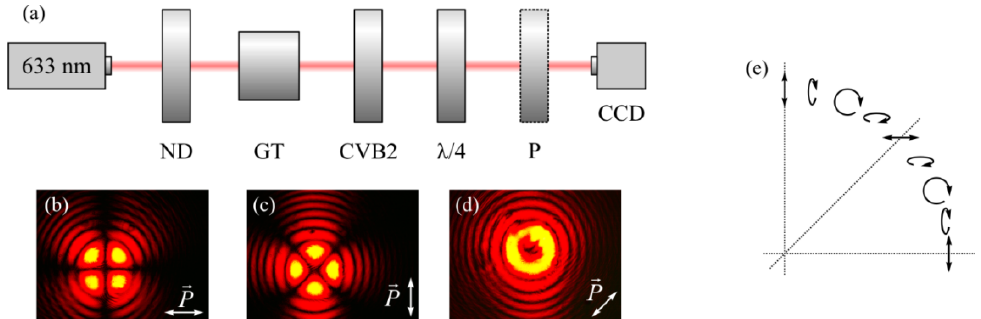
Figure 8. ( a ) Optical setup for the generation and registration of a hybrid polarized beam (Equation (1)) of the second-order m = 2, with the analyzer placed ( b ) horizontally ( θ = 0 degrees), ( c ) vertically ( θ = 90 degrees), and ( d ) at an angle of θ = 45 degrees. ( e ) The experimentally reconstructed depend- ence of the polarization state on the polar angle φ in quadrant I.